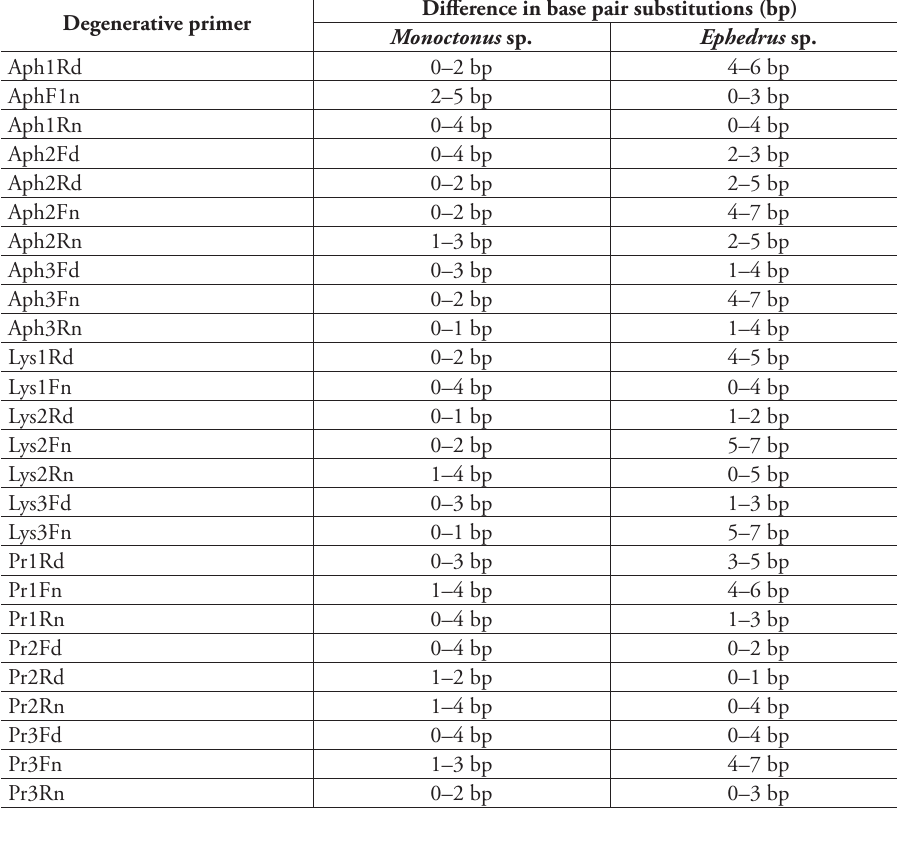
Table 4. Comparison of barcode fragments of COI for Monoctonus and Ephedrus with degenerative primers sequences.